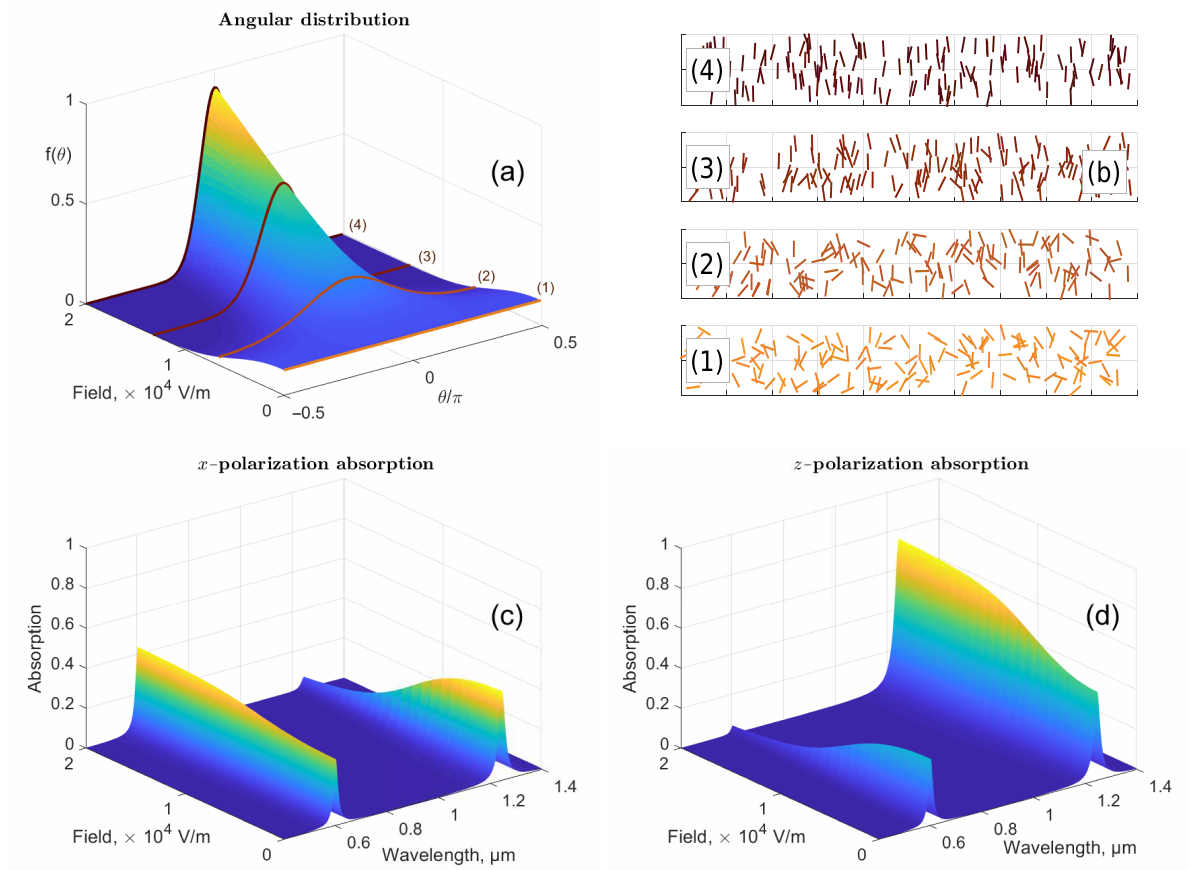
Figure 1. Influence of the external electric field on the characteristics of the particle suspension. ( a ) Angular distribution function as a function of the external electric field. For easier visualization, the definition domain of θ ∈ [ 0, π ] was translated into [ − π /2, π /2 ] . ( b ) Examples of particle distributions at four different values of external field, E = 0.0 (1), 6.6 (2), 13.2 (3), and 20.0 (4) kV/m. Indices (1)–(4) correspond to those in ( a ); the corresponding distribution functions were used to simulate the random distributions shown in ( b ). Absorption of an EMW in an LMC slab as a function of frequency and external electric field for: ( c ) x -polarization, and ( d ) z -polarization. The plots were calculated for ellipsoidal 10 nm × 80 nm gold nanorods (aspect ratio of 8) in water at a concentration of 10 13 mL − 1